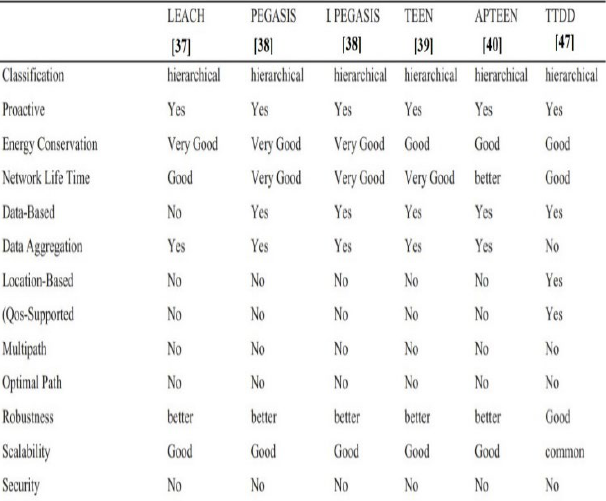
Table 3. Performance Comparison Hierarchical Based Routing Protocols